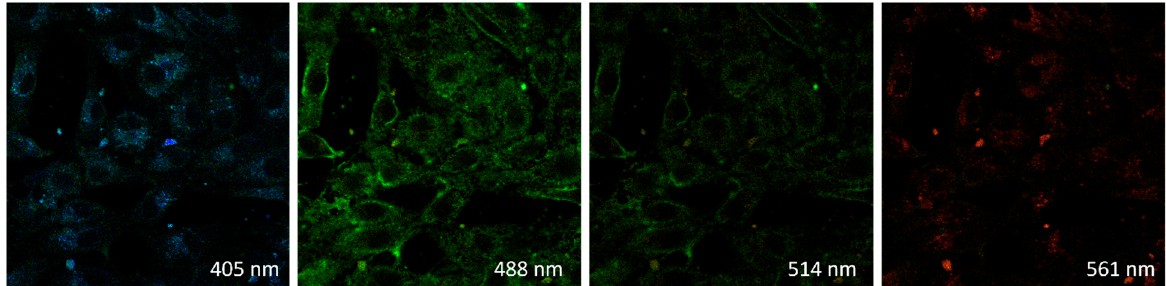
Figure 11 . Staining of Vero culture cells with complex 10a . Images for different excitation wave- lengths (405, 488, 514 and 561 nm) are presented.